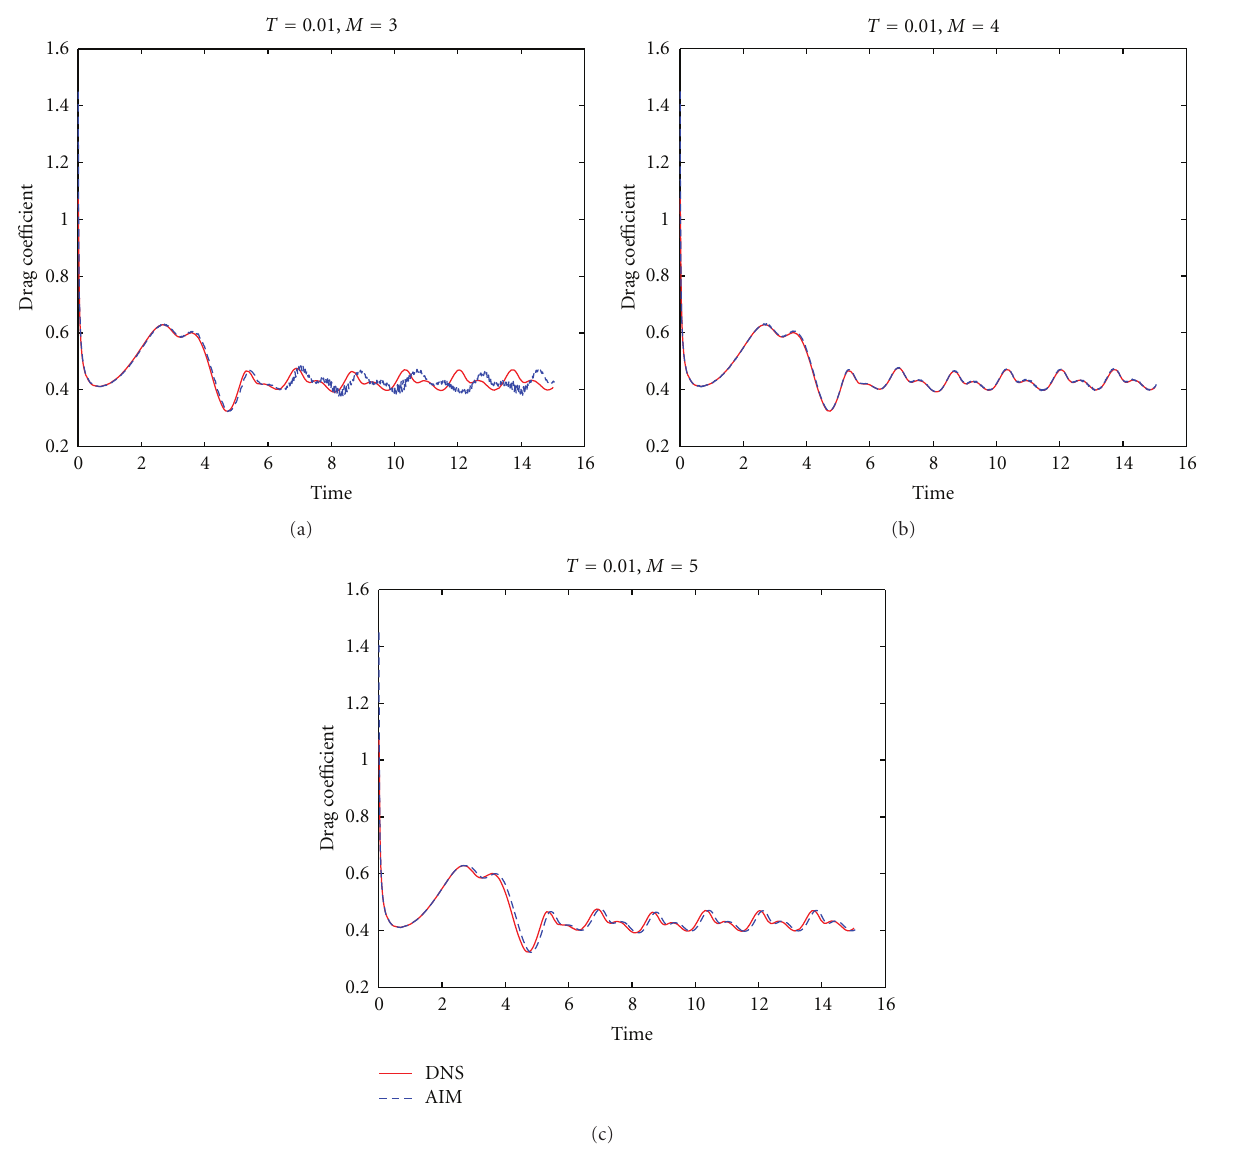
Figure 6: Transient dynamics: Re = 800, drag coe ffi cient for T = 0 . 01 with various number of M . From top to bottom: M = 3,4, and 5.